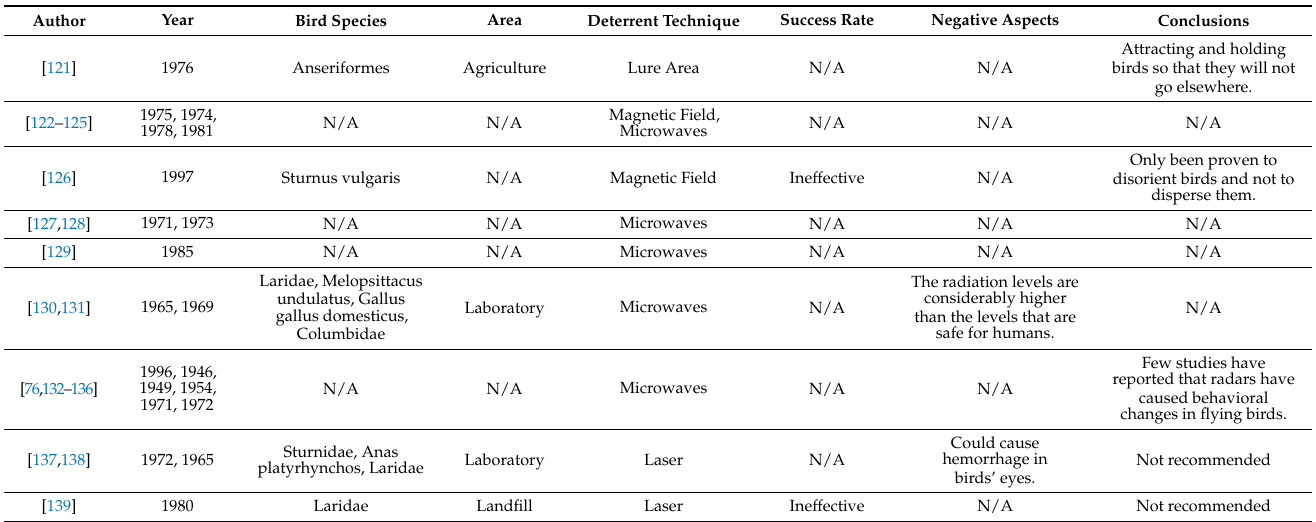
Table 7. Summary of the studies using other deterrent